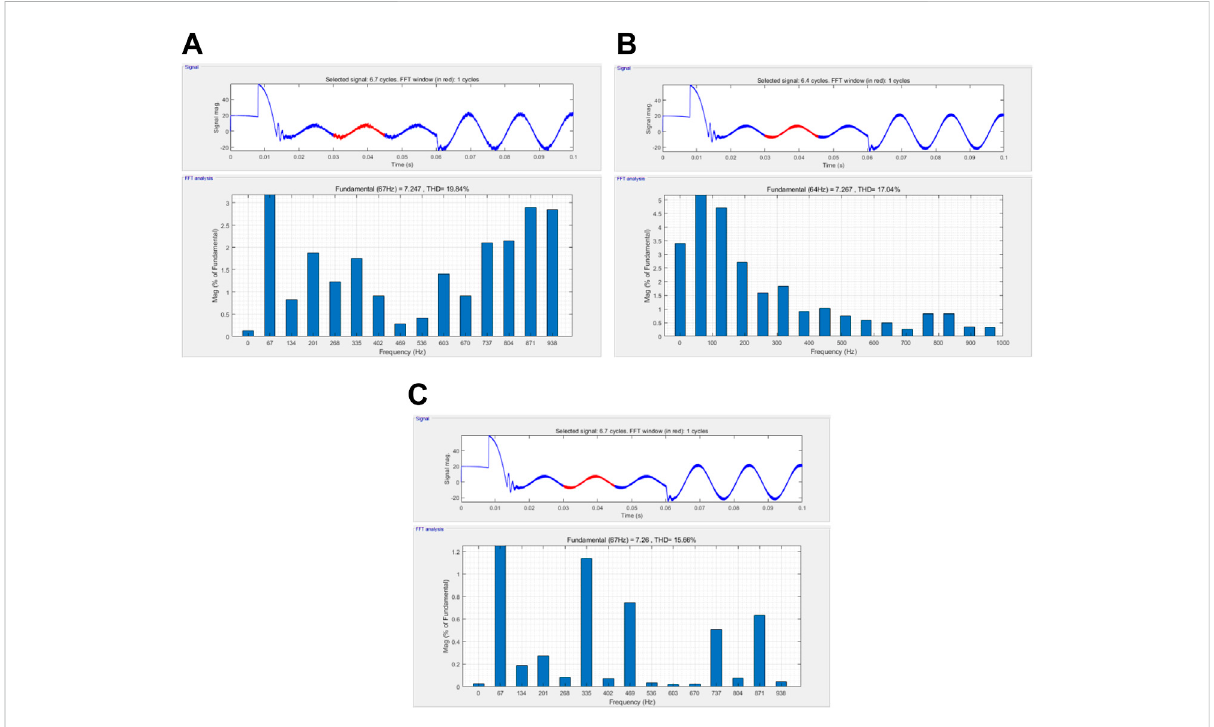
FIGURE 8 (A) Harmonic analysis of the motor stator A-phase current with the SMO based on the sgn function; (B) harmonic analysis of the motor stator A-phase current withtheSMO basedon thesigmoidfunction; (C) harmonicanalysis ofthemotor stator A-phase current withtheSMO basedonthe piecewise power